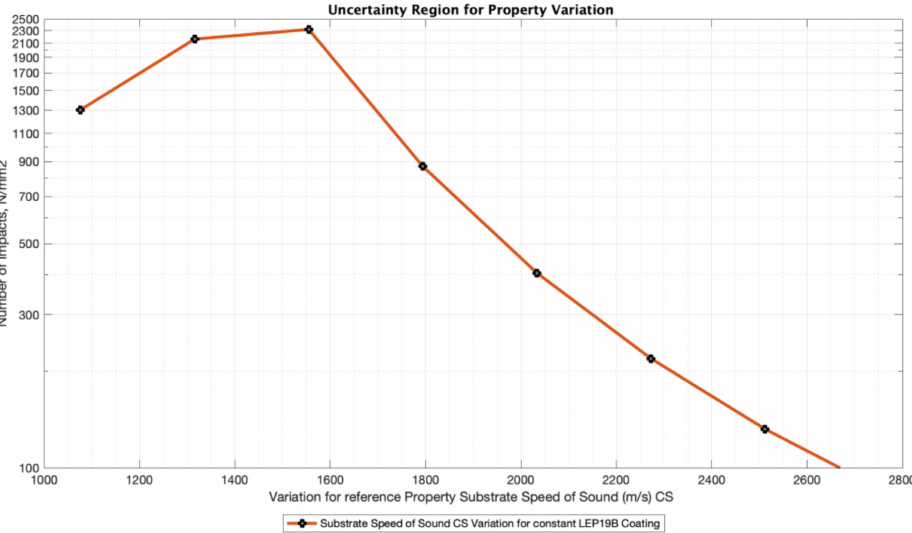
Figure 25. Incubation time (Number of impacts until failure) numerical estimation, due to a unique variation of the substrate wave speed CS when considering the LEP19B material as the substrate